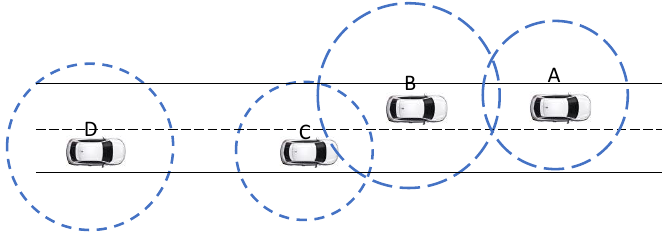
Figure 10. Conceptual illustration of the topological vehicle sequence shown in Figure 9.